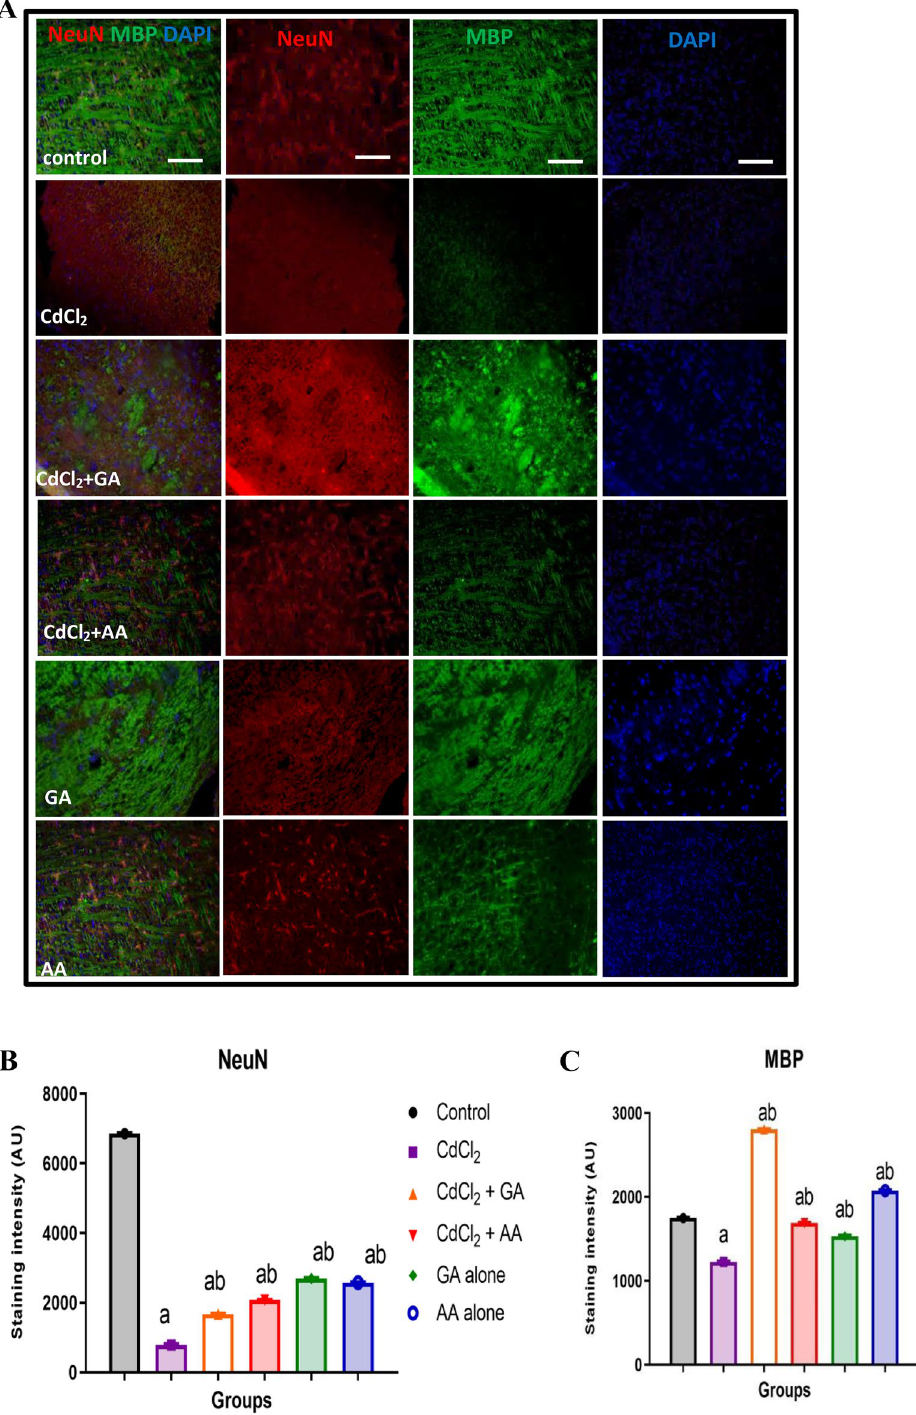
Figure 8. ( A ) Representative double immunofluorescence stainingphotomicrograph showing neuronal nulei (NeuN; red), myelin basic protein (MBP; green) and cell nuclei (DAPI; blue) in the brain cortex in experimental rats. Quantification ofstaining intensity of ( B ) NeuN and ( C ) MBP was performed using ImageJ software. GA gallic acid, AA ascorbic